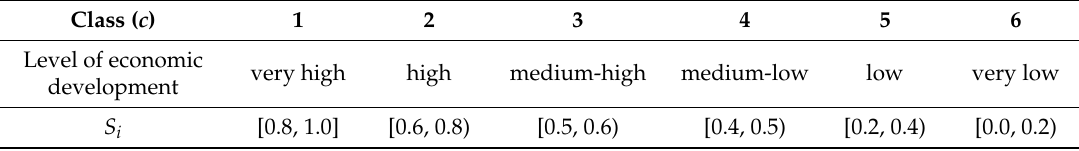
Table 1. Classes, levels of economic development and value intervals of synthetic measure. Class ( c ) Level of